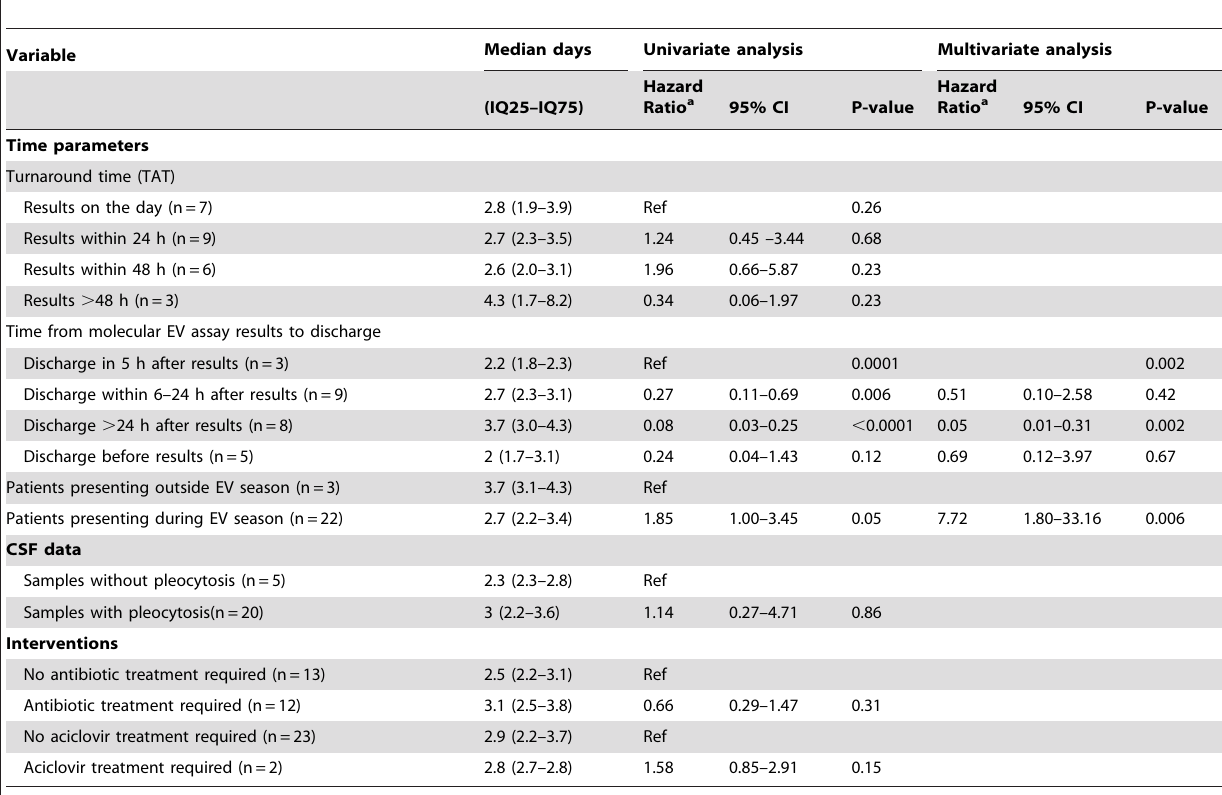
Table 3. Univariate and multivariate analysis of factors associated with hospital length of stay in infants (n =25) with enterovirus (EV) meningitis during the two study periods